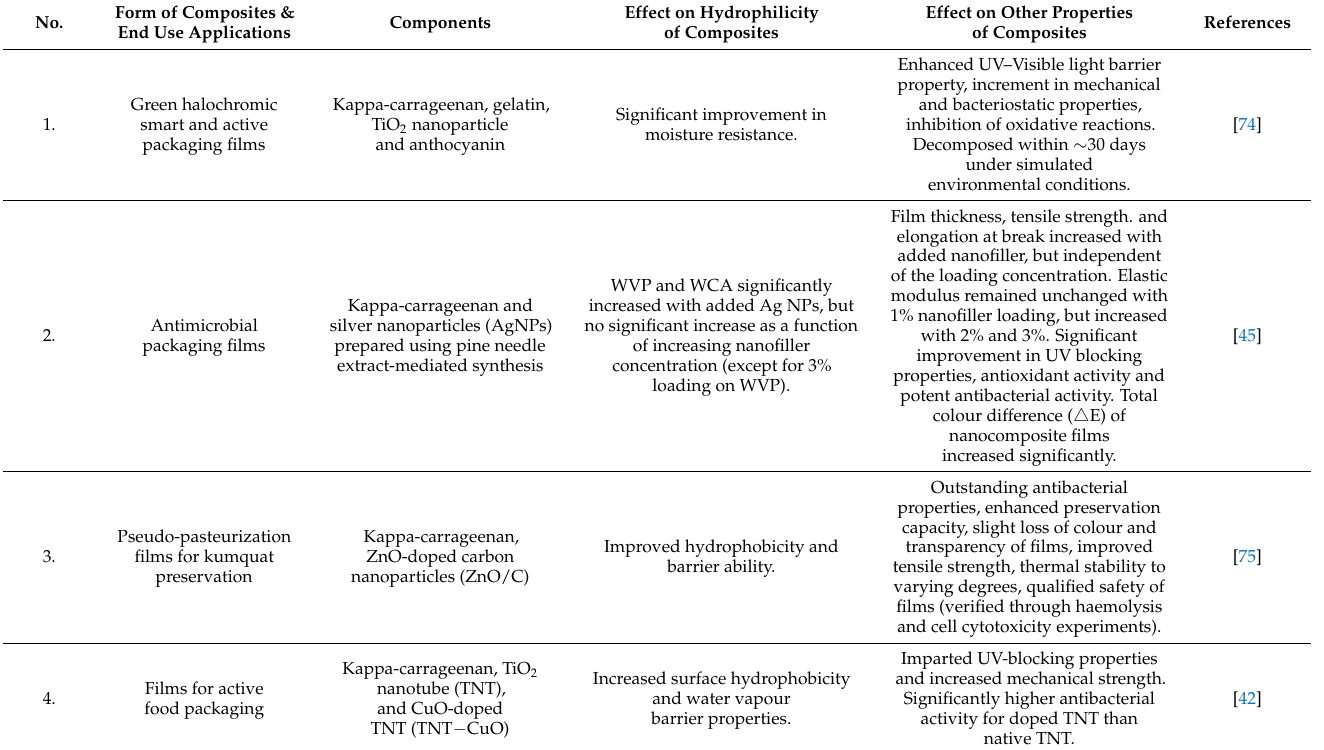
Table 10. Role of metal oxide nanoparticles, nanotubes, and carbon dots in the carrageenan nano- Table 10. Roleofmetaloxidenanoparticles, composites.